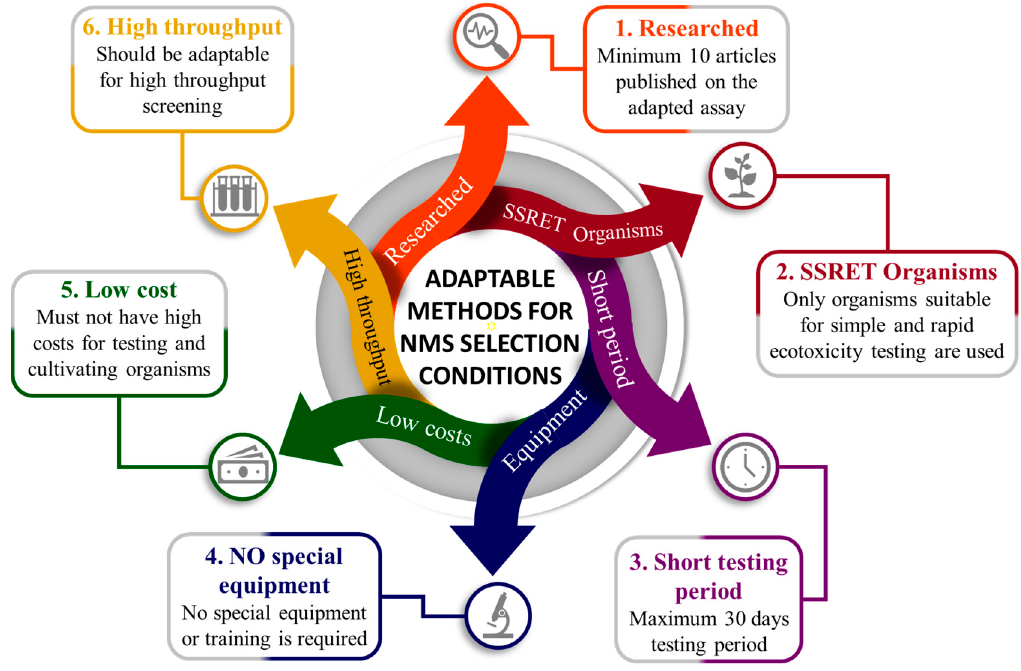
Figure 6. Condition for the selection of standard methods for ecotoxicity assessment that can be adapted for nanomaterial.